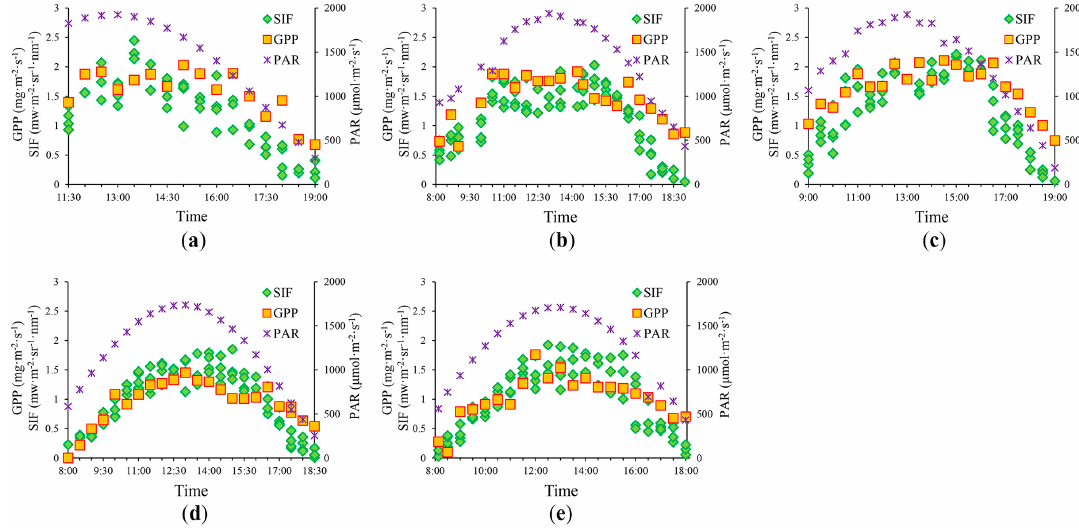
Figure 3. Diurnal patterns of PAR, GPP and SIF 760 during the experiment: ( a ) 10 July; ( b ) 17 July; ( c ) 18 July; ( d ) 21 August; and ( e ) 22 August.